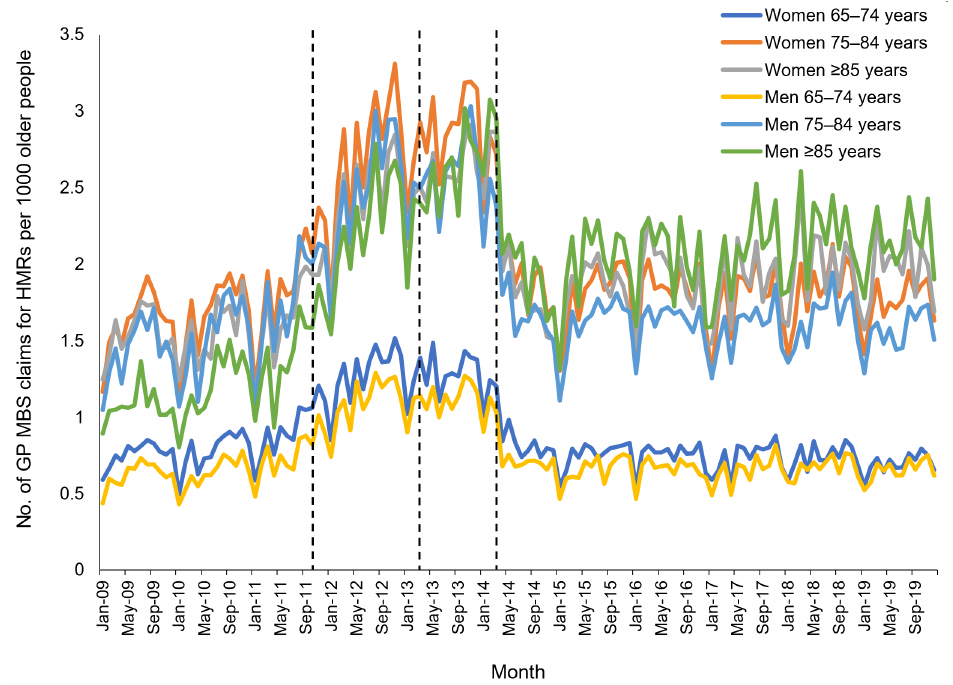
Figure 1. Monthly rate of GP claims for Home Medicines Reviews (HMRs) per 1000 older persons between 2009 and 2019, stratified by age group and sex. Dashed lines indicate dates of program changes .